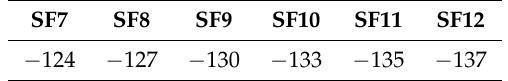
Table 1. The sensitivity threshold (in dBm) for a specific spreading factor (SF).